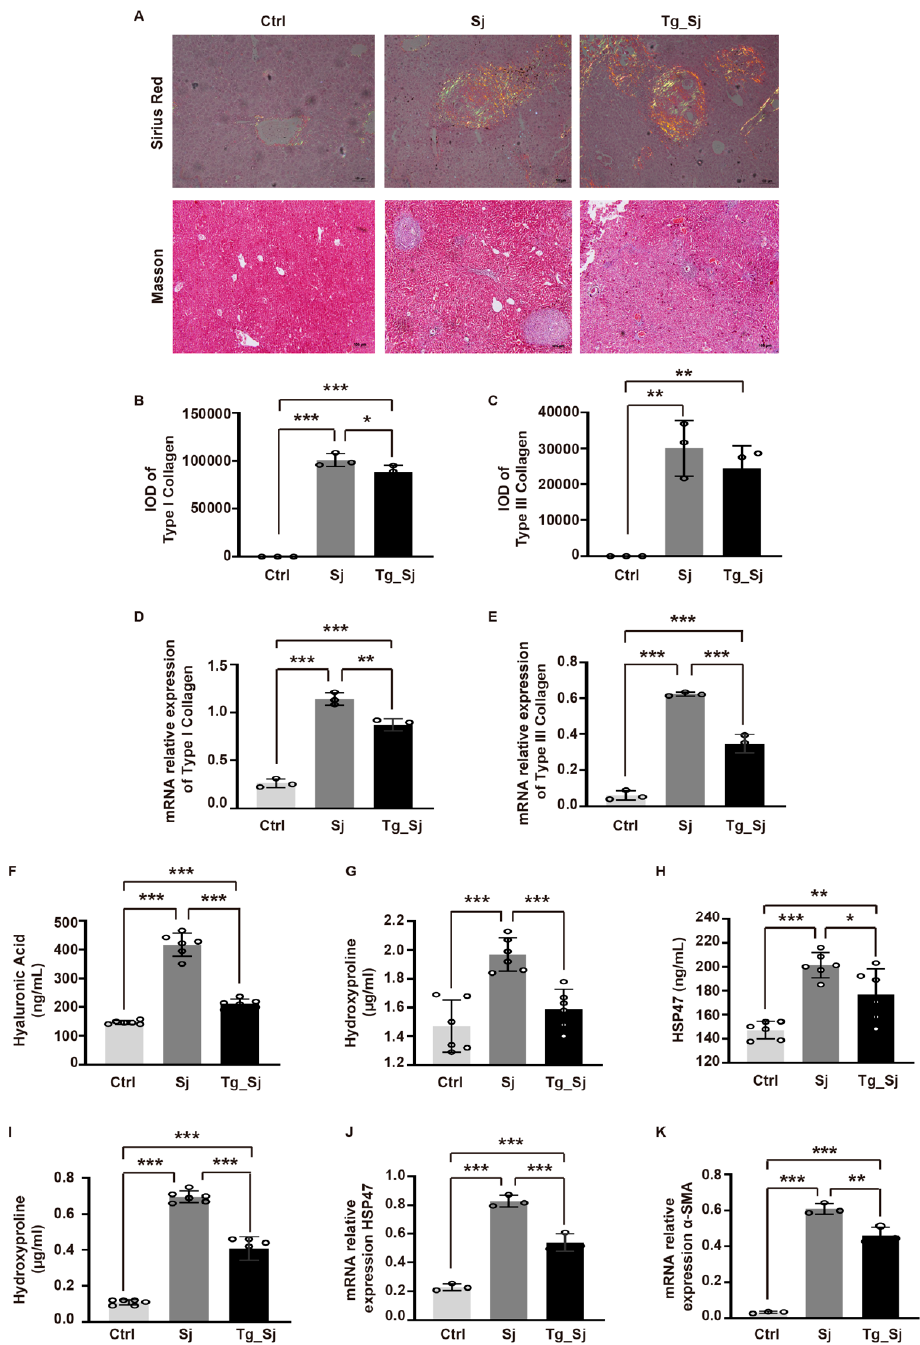
Figure 2. Co-infection of T. gondii and S. japonicum suppresses hepatic granuloma formation and fibrosis in mice. ( A ) Upper panel: Sirius red staining of collagen type I (orange or red) and collagen type III (green); Lower Panel: Masson trichrome staining of collagens (blue), images were taken by polarized light microscope, scale bar 100 µ m. ( B , C ) Quantification of collagen type I and type III by Image pro plus 6.0. ( D , E , J , K ) The mRNA levels of collagen type I, type III, heat shock protein 47 (HSP47) and α -smooth muscle actin (SMA) in liver tissues were determined using real-time PCR. Data are normalized to GAPDH and expressed as arbitrary units. ( F , H ) The concentrations of serum hyaluronic acid (HA), HSP47 were determined by ELISA. Hydroxyproline (HYP) in serum ( G ) and in liver tissues ( I ) was detected by alkali pyrolysis and analyzed with semi-automatic biochemical analyzer (colorimetric wavelength: 550 nm). Results are representative of at least three independent experiments ( B – E , J , K , n = 3, F-I, n = 6, one-way ANOVA). * p < 0.05, ** p < 0.01, *** p <